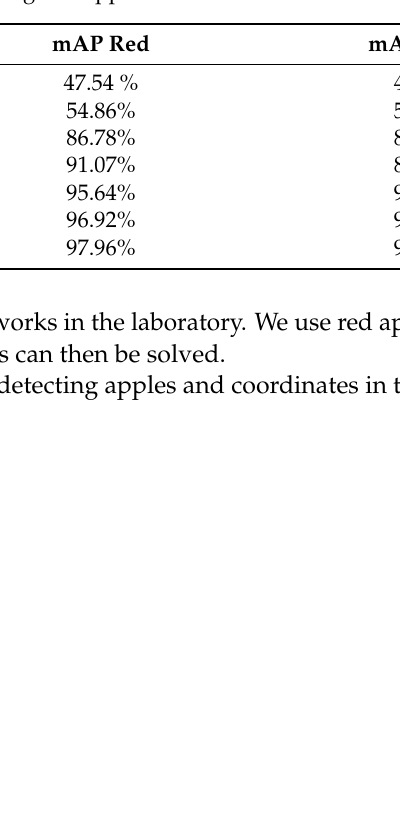
Figure 9. Positioning apples in 3D (Apple Confidence: 0.87, X: 1.26 mm, Y: 40.67 mm, Z: 447.0 mm).